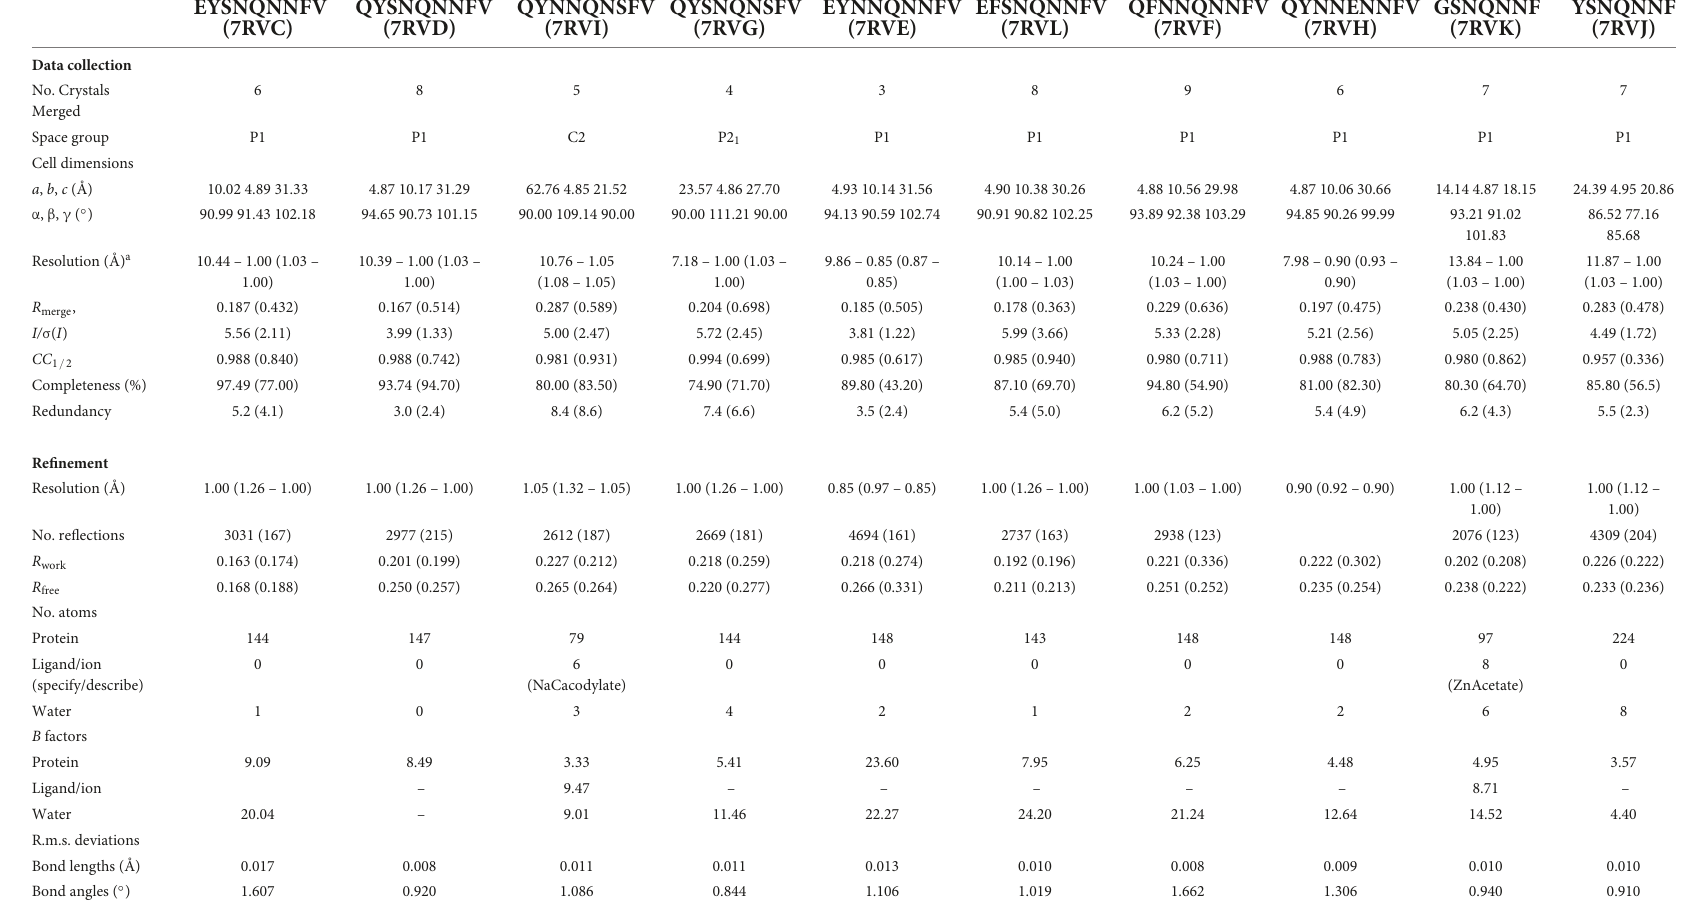
TABLE 2 Data collection and refinement